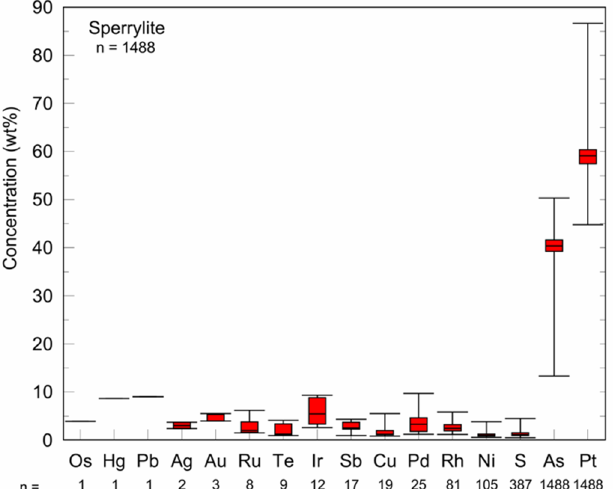
Figure 7. Multi-element box and whisker plot showing elemental variation (in wt%) in the compo- sition of 1488 sperrylite grains. Whiskers represent the range of minimum and maximum values. The short line within each box represents the median value, which separates the box into two parts (i.e., lower 25th–50th percentile group and upper 50th–75th percentile). The n below the axis: number of grains containing the element of interest.